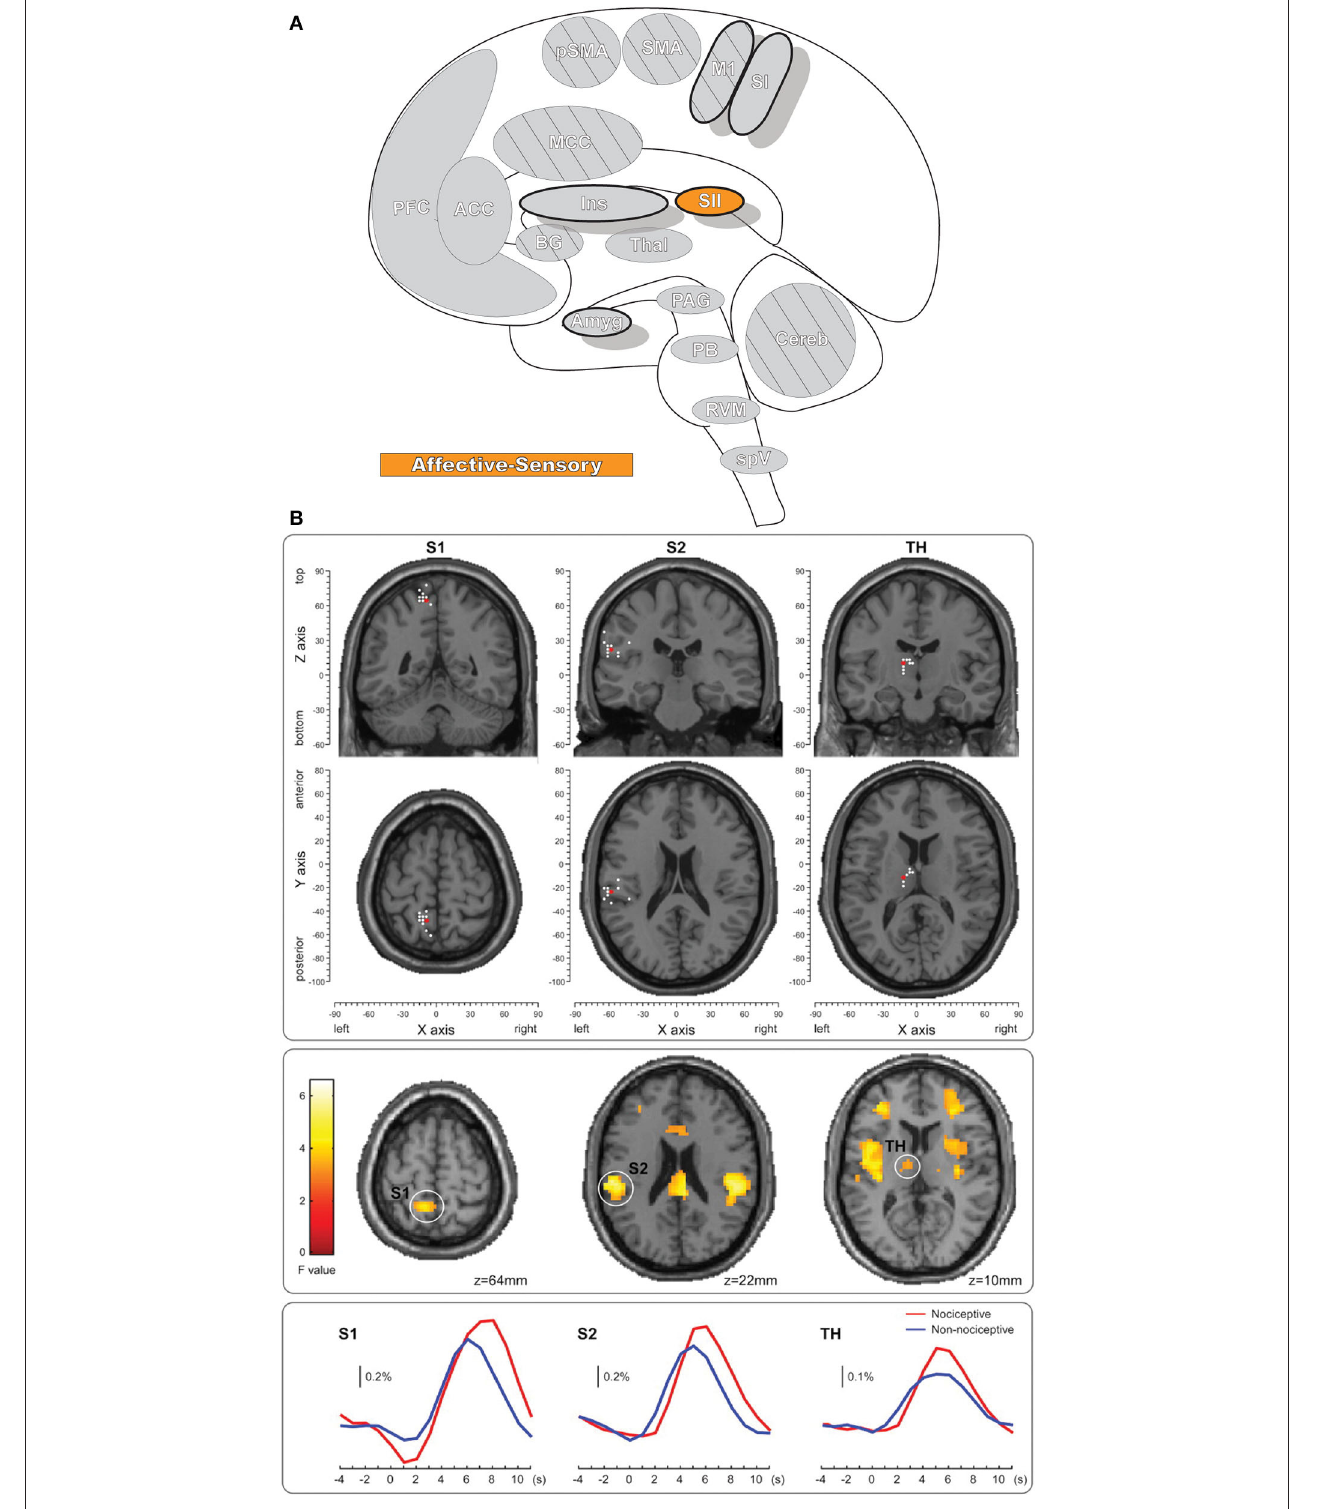
FIGURE 4 | Secondary somatosensory cortex. (A) Brain areas active during pain: secondary somatosensory cortex (SII) highlighted. (B) fMRI recordings during nociceptive and non-nociceptive stimulation in SI, SII, and Thalamus. The consistent time courses across all three regions suggest parallel information processing in the primary and secondary somatosensory cortices, along with associated activations in the thalamus. Reprinted from The Journal of Neuroscience, Vol 31(24),